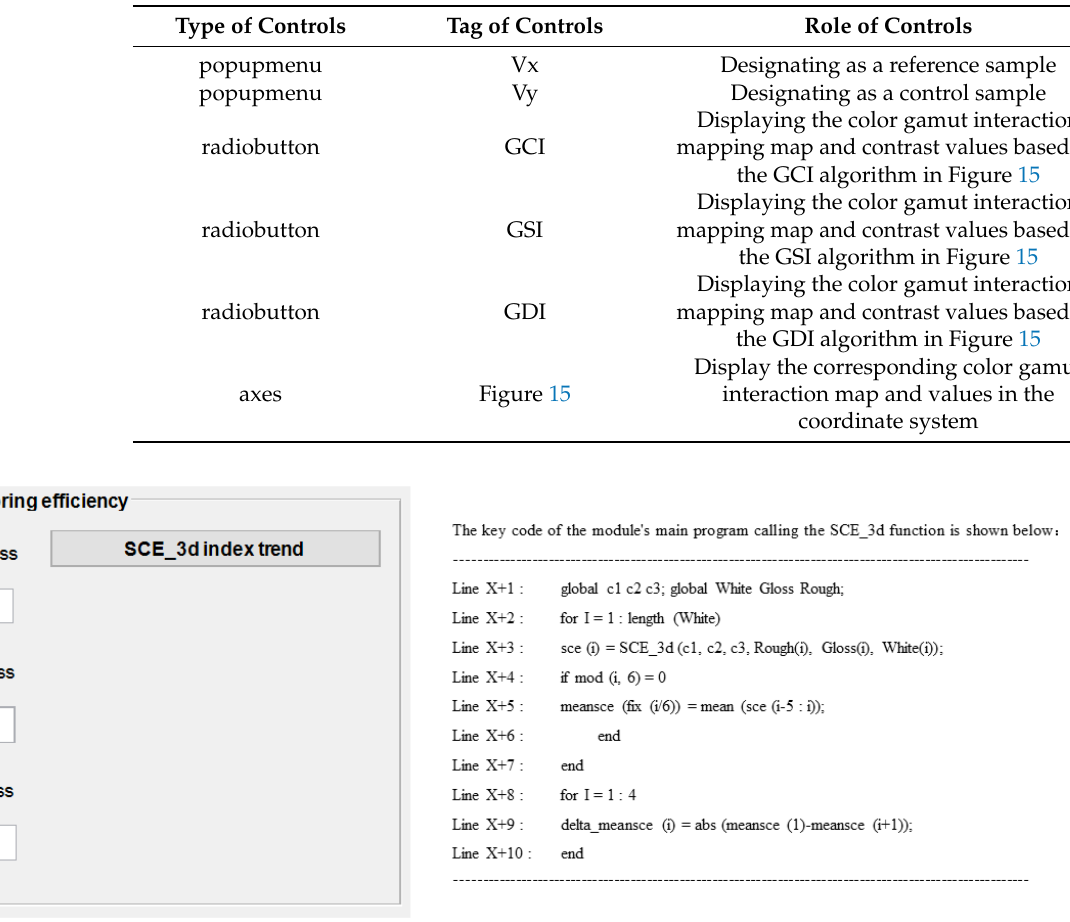
Figure 16. Interface design and demonstration of its calling codes in Module 6. Table 6. Types, labels and roles of controls used in the Module 6 interface.